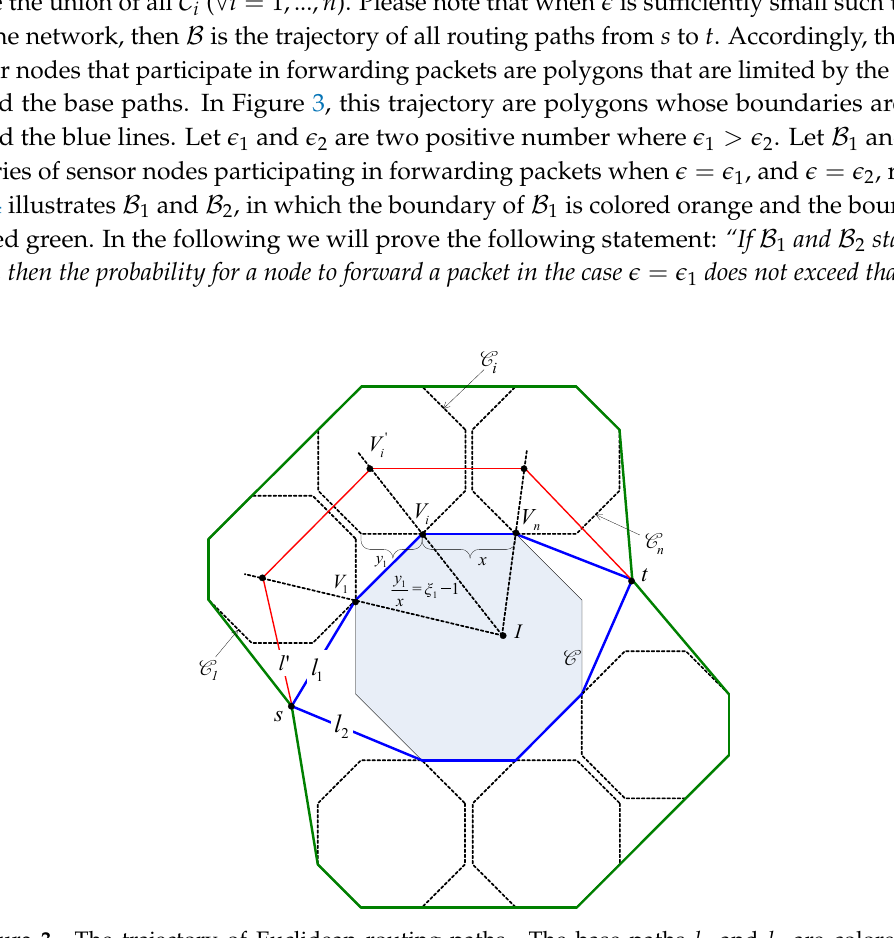
Figure 3. The trajectory of Euclidean routing paths. The base paths l 1 and l 2 are colored blue, the Euclidean path l (cid:48) is colored red [38].